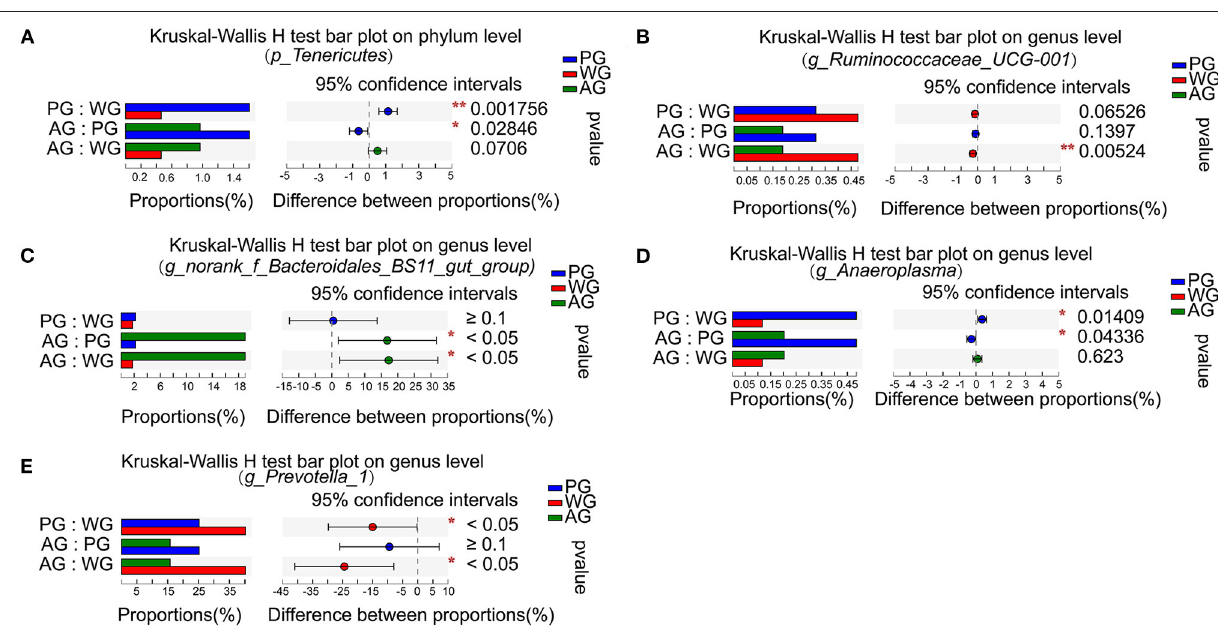
FIGURE 4 | Difference of rumen bacteria at the phylum and genus level. (A) Analysis on the difference of p_Tenericutes abundance at phylum level. (B) Analysis on the difference of g_Ruminococcaceae_UCG-001 abundance at genus level. (C) Analysis on the difference of g_norank_f_Bacteroidales_BS11_gut_group abundance at genus level. (D) Analysis on the difference of g_ Anaeroplasma abundance at genus level. (E) Analysis on the difference of g_ Prevotella_1 abundance at genus level. WG, wheat straw group, n = 4; PG, peanut vine group, n = 4; AG, alfalfa hay group, n = 4. * P < 0.05, ** P <